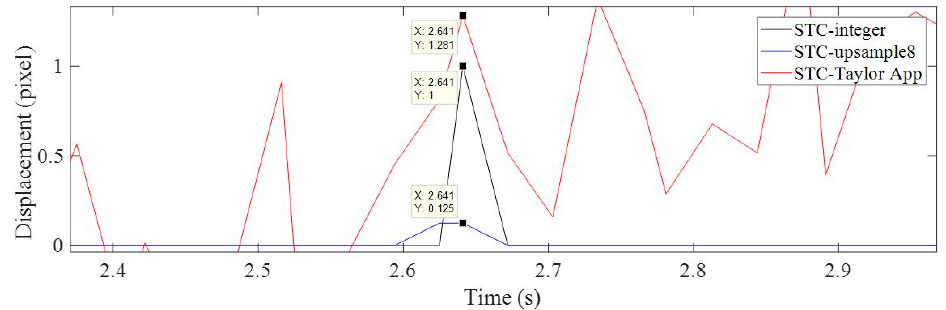
Figure 11. A zoomed in section of the horizontal displacement time histories of P1 in pixel